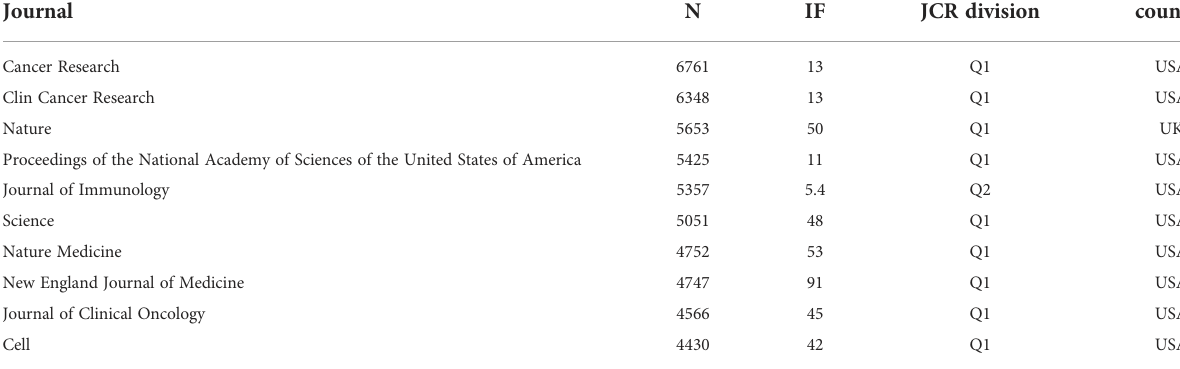
TABLE 2 The top 10 co-cited journals of immunotherapy-TME-related